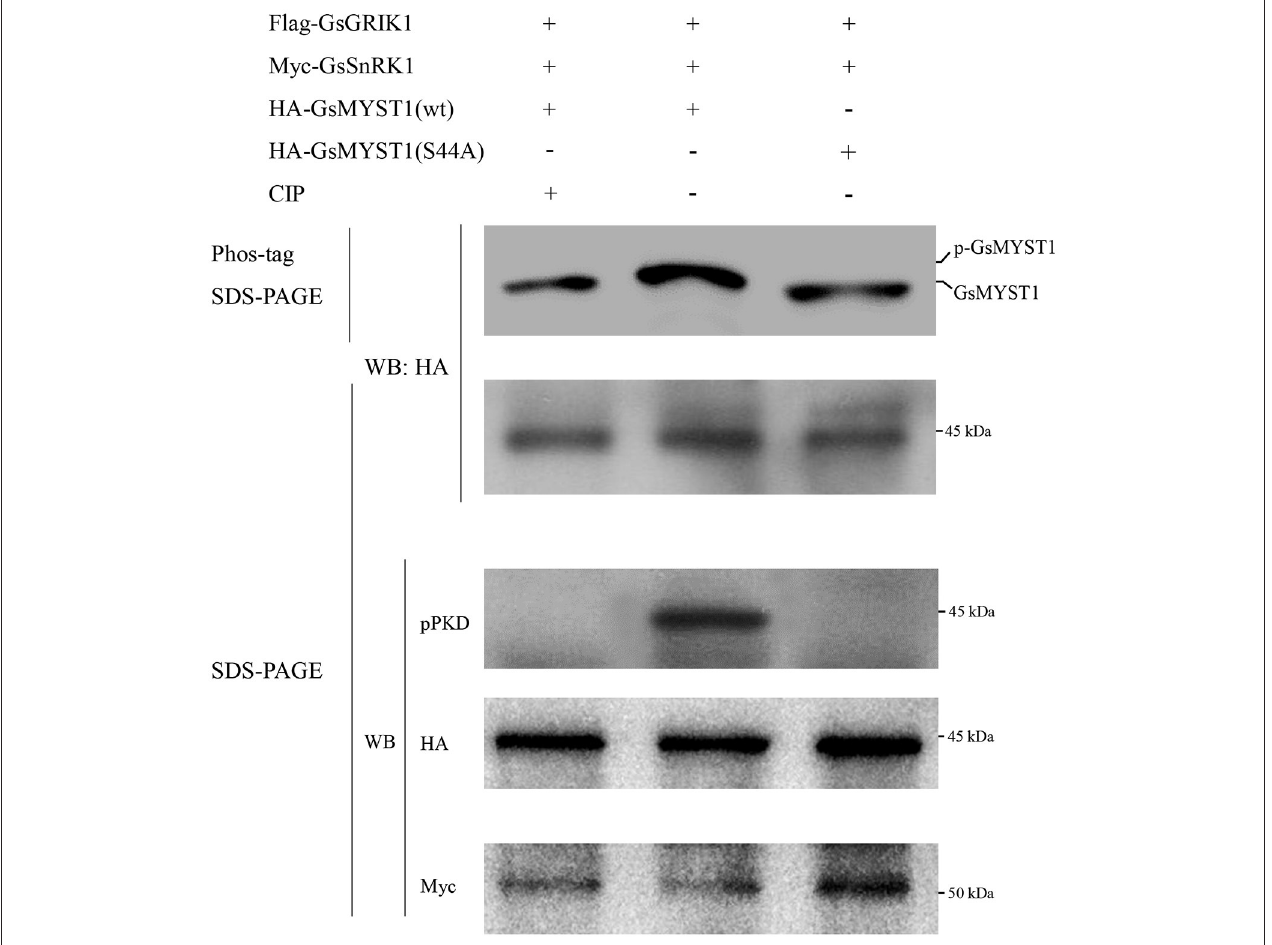
FIGURE 4 | In vitro GsMYST1 phosphorylation assay. GsSnRK1(wt), GsMYST1(wt), and their mutants were expressed and purified in E. coli . The indicated proteins were combined and incubated for kinase reactions. The reactants were fractionated in SDS-PAGE gels with or without Phos-tag. The membranes were, respectively, blotted with the indicated antibodies to show the protein phosphorylation status and loading controls. Each representative figure is shown from three biological